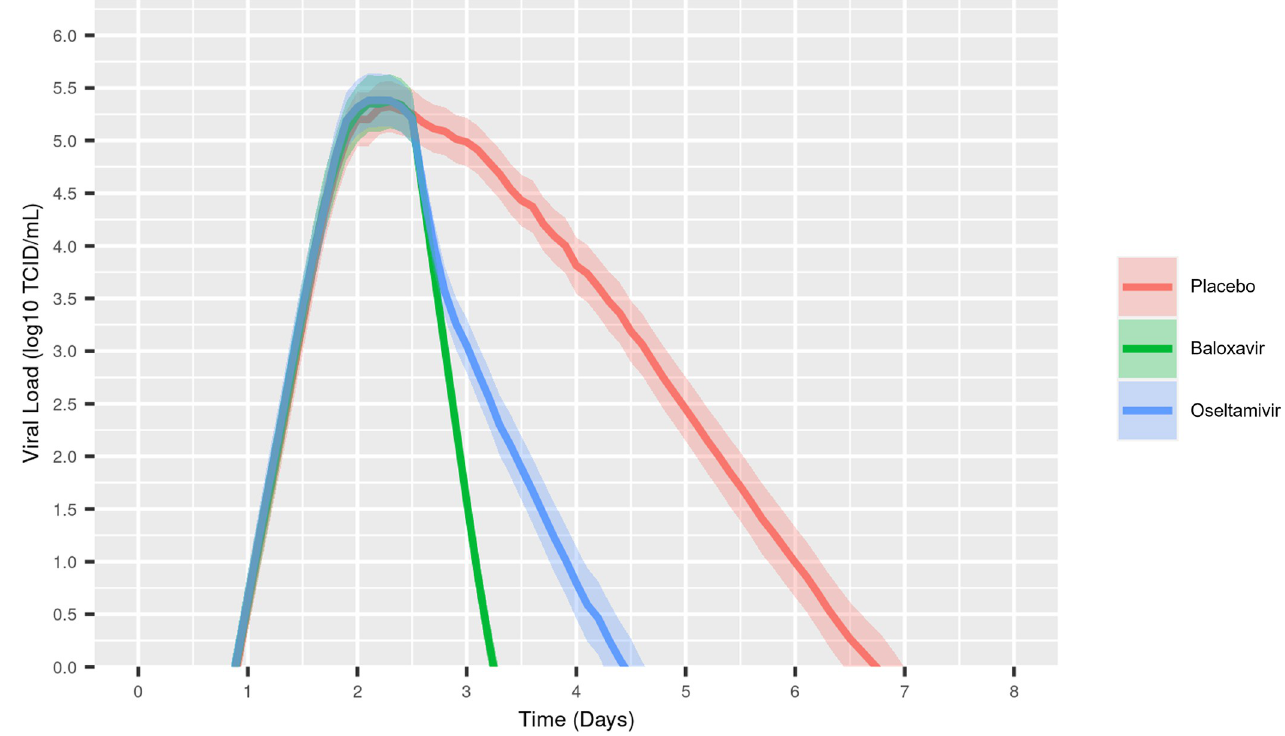
Fig 2. Influenza virus titer time course in response to antiviral treatment, simulated using the pharmacokinetic–viral kinetic model. The line represents the median of 1000 simulated individuals with the shaded areas corresponding to the 95% confidence interval around this median. Symptoms were assumed to start 36 hours after infection, and treatment was administered 24 hours after symptom onset (sampled from the observed distribution).